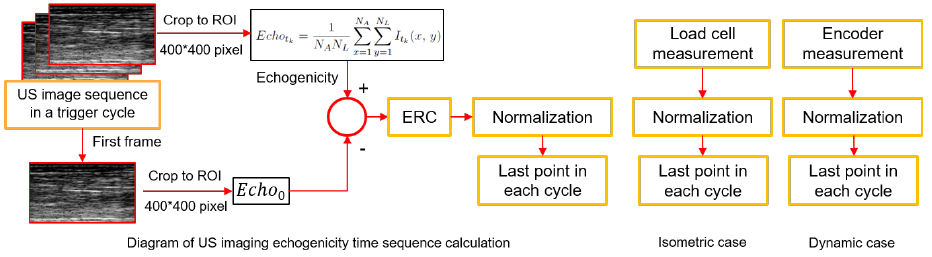
Figure 2. Diagram of data processing, including US imaging echogenicity, load cell, and encoder measurements under both isometric and dynamic